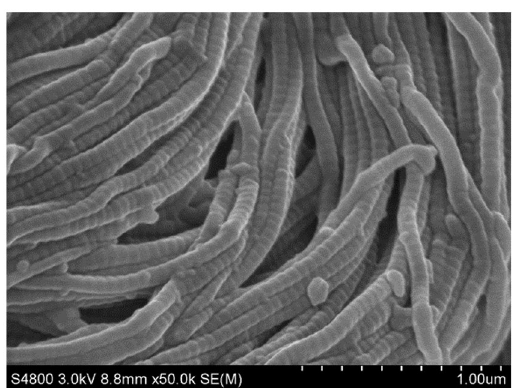
Figure 9. SEM image of cross-section of leather treated by MHCO/GPTMS-ZnO